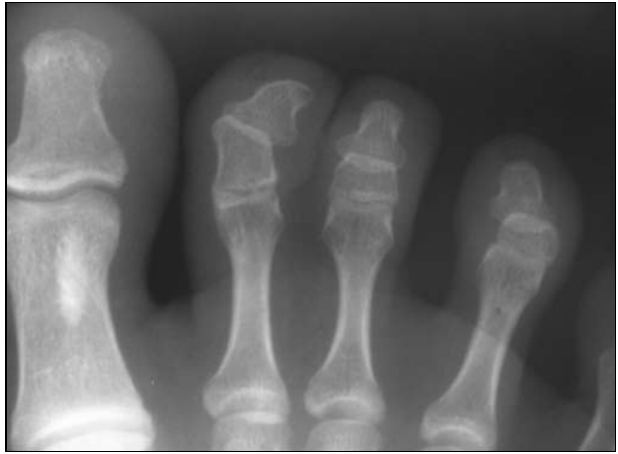
Fig. 5. Radiograph showing soft-tissue fusion of 2nd and 3rd toes. Note too bone island on the big